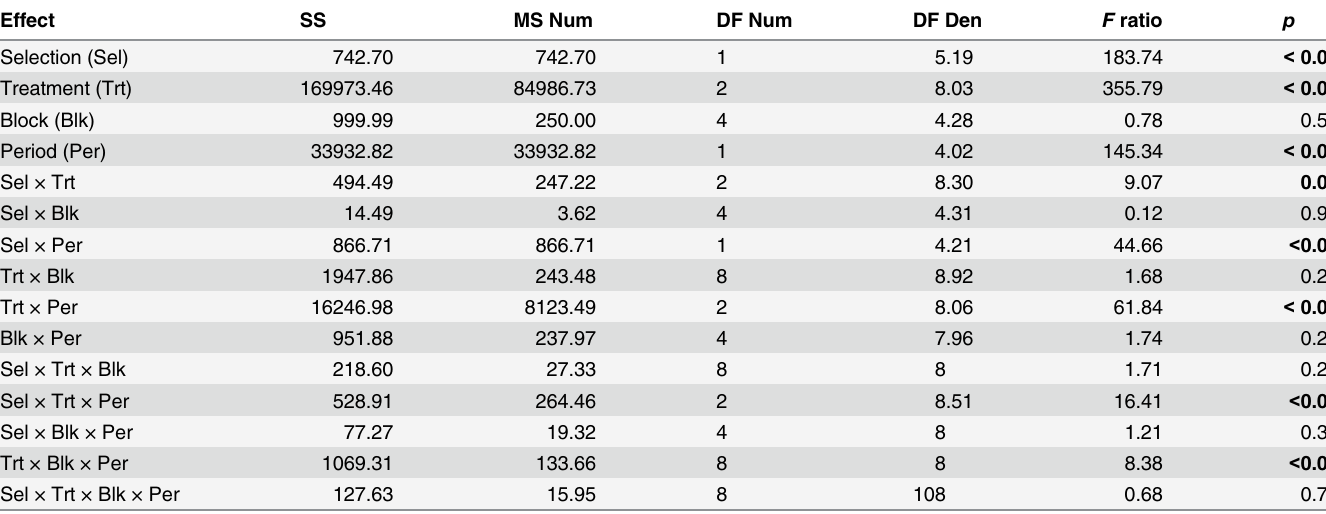
Table 1. Effect of cold shock on egg viability (Experiment 1).